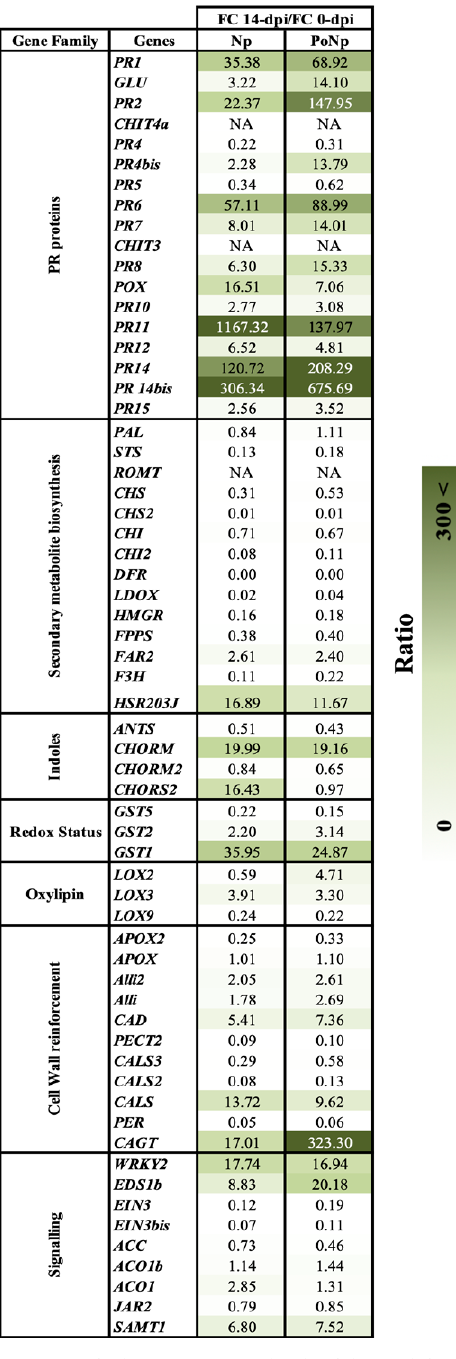
Figure 7. Ratios of relative expression levels of the 62 defence genes in grapevine wood between 0 d post inoculation (dpi: 5 h after inoculations) and 14 dpi. Gene expression of mock-controls was used as the reference to calculate relative gene expression. Each col- umn represents the time point after treatment (Np = Neofusicoccum parvum and PoNp = Pythium oligandrum + N. parvum ), and each line corresponds to one gene represented by a single row of boxes. Color gradient from blank (low values) to dark green (high values) was used to indicate the magnitude of FC